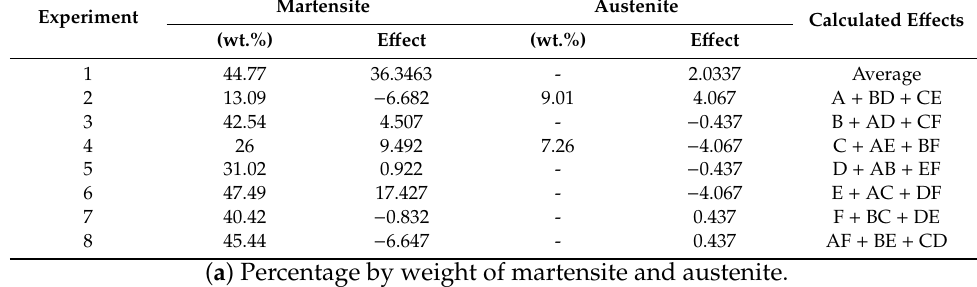
Table 8. Average values and e ff ects obtained for the phases present in the material. Experiment